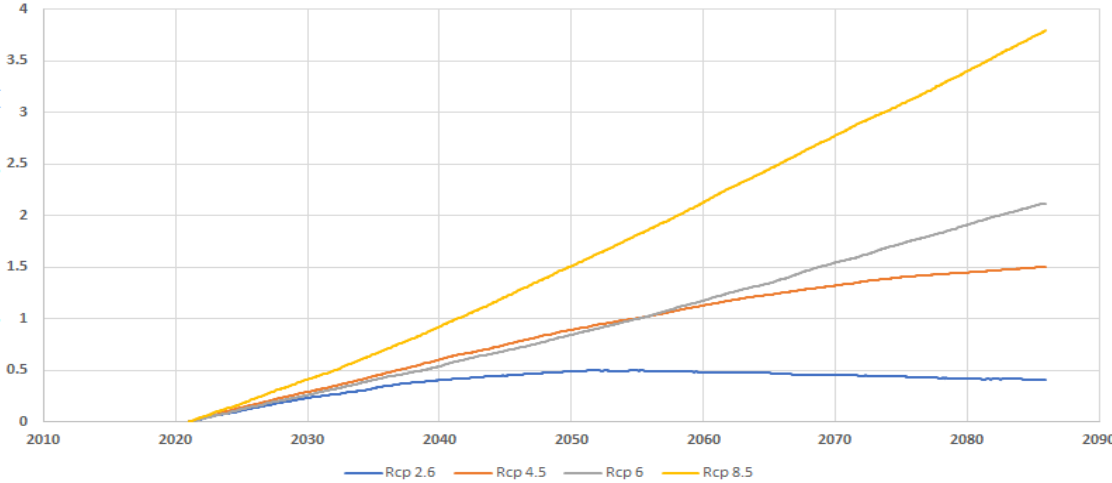
Figure 20. Thirty-year running annual means of projected surface air temperatures (Tas) under the four representative concentration pathway scenarios studied (RCP2.6, RCP4.5, RCP6.0, and RCP8.5) relative to the 2006–2035 period for the mini-Ensemble mean GFDL model simulation in Aswan High Dam Reservoir.